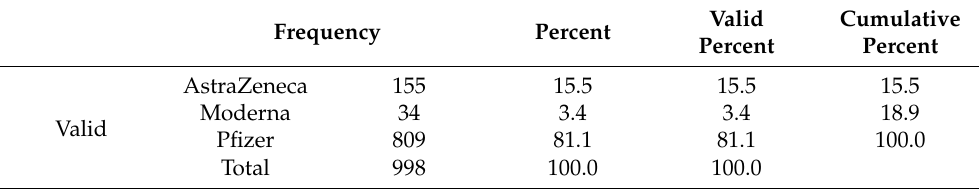
Table 1. Frequency of different types of vaccines administered by respondents in the study.